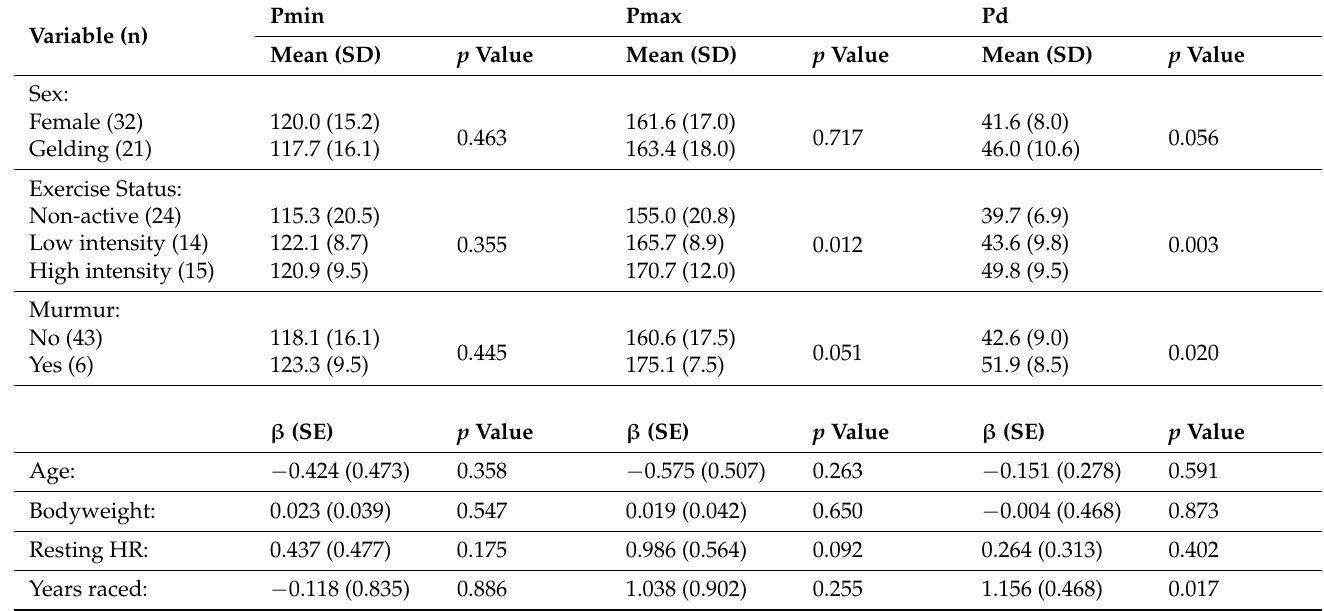
Table 2. Univariable linear regression of the relationship between each variable and Pmin, Pmax and Pd. Means (standard deviations) for fixed effects, Sex, Exercise Status and Murmur,